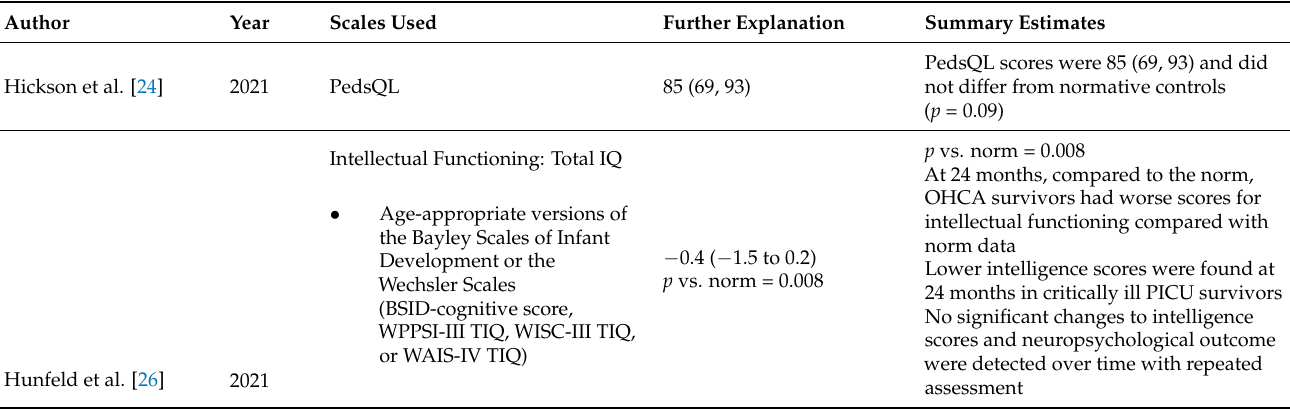
Table 2. Health-Related Quality of Life